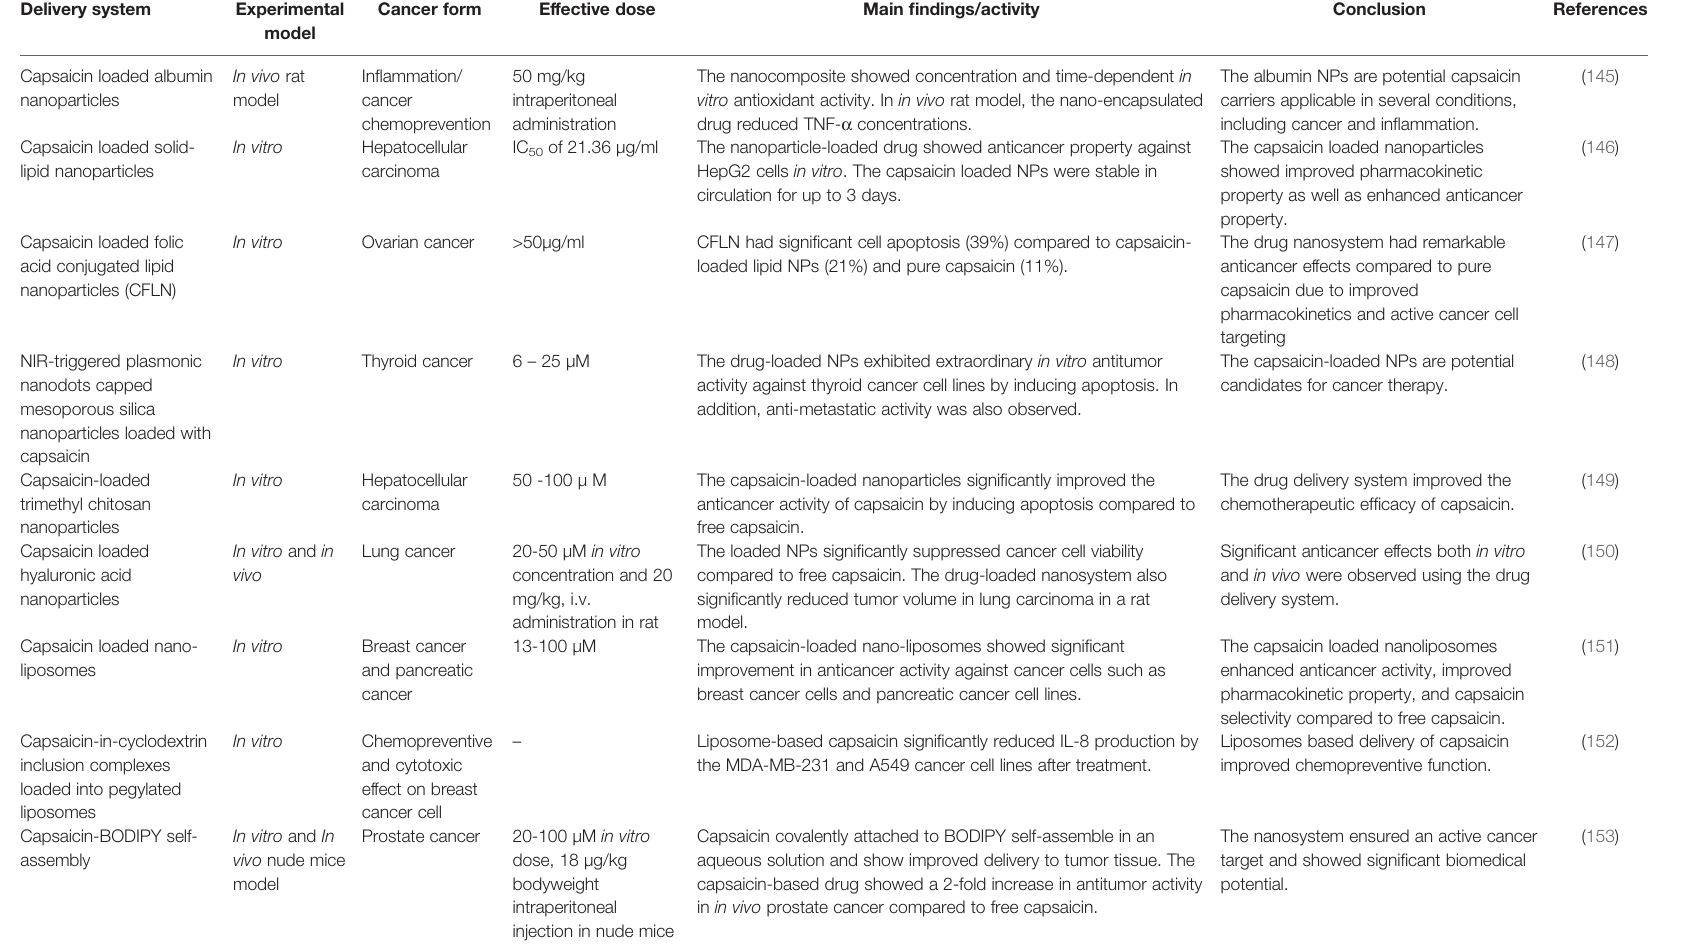
TABLE 1 | Recent examples of anticancer studies focusing on capsaicin